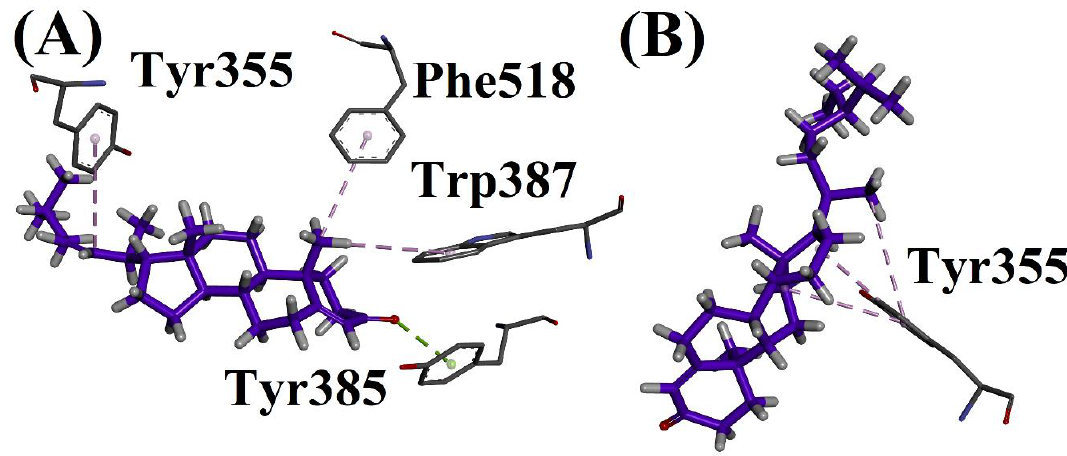
Biomolecules 2022 , 12 , 1430 Figure 4. ( A ) Interactions of compound 1 and ( B ) Interactions of compound 2 in active site of 1EQG.